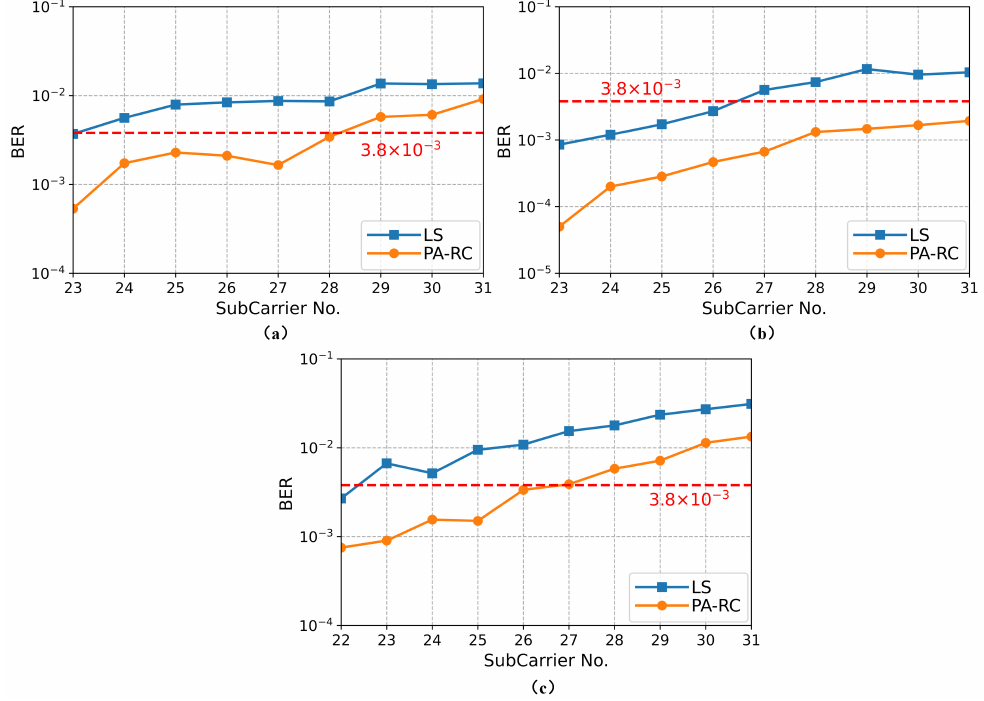
Figure 7. BER vs. Subcarrier number under the rate of 240 Mbps. ( a ) The Vpp is 0.6 V; ( b ) the Vpp is 1.2 V; ( c ) the Vpp is 1.5